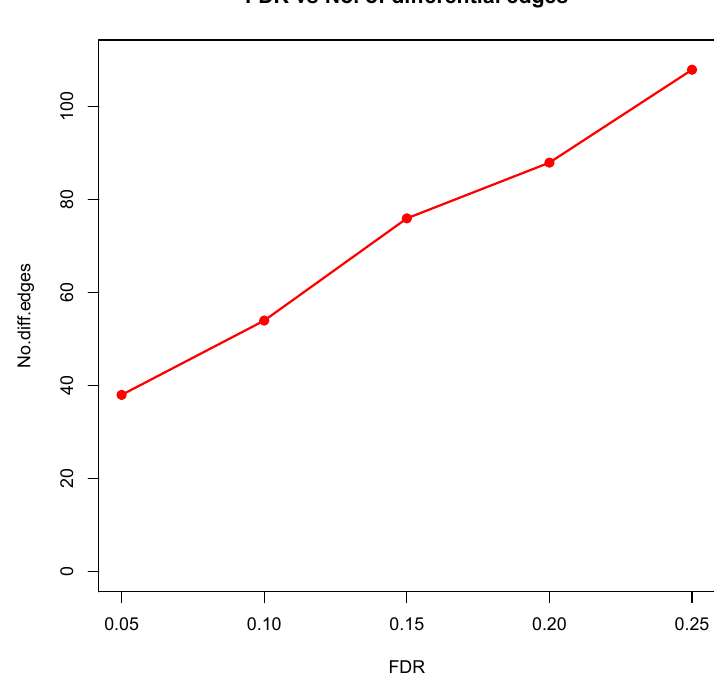
Figure 8. Desired FDR level against the number of differential